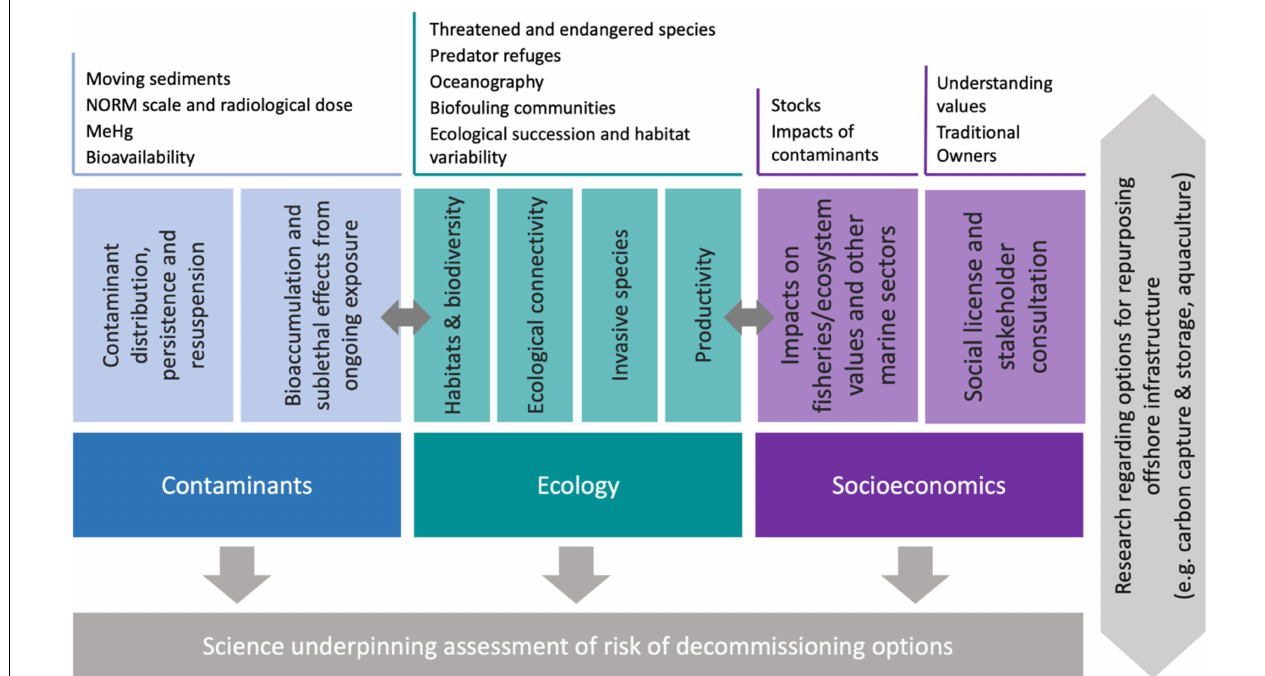
FIGURE 5 | A general framework for integrated research to assess the risk of decommissioning options for oil and gas infrastructure in